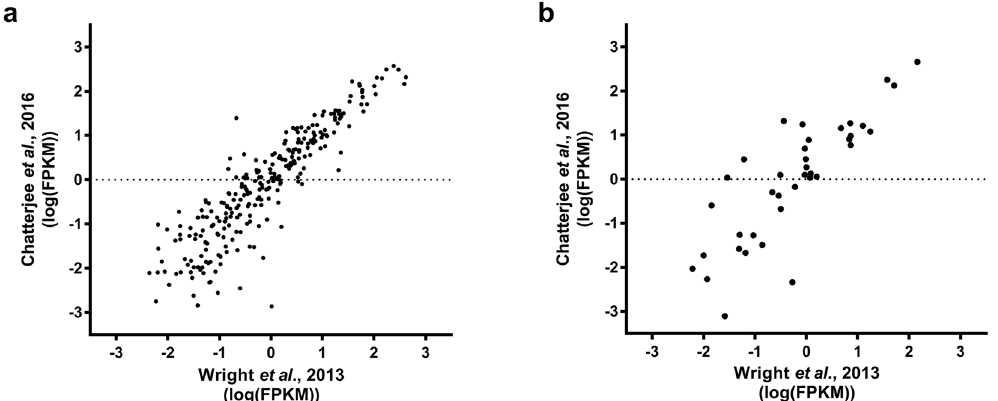
Figure 3. Expression of human SLC and ABC transporter proteins across two different datasets shows highly significant positive correlation. Scattergraphs show comparison of expression of ( a ) SLC and ( b ) ABC transporter proteins in datasets by Wright et al . and Chatterjee et al . 21, 33 . Data points represent the mean of replicate values. Any genes in the Wright et al . dataset which could not be identified in the Chatterjee et al . dataset are not shown. For ( a ), r = 0.9157, P < 0.0001 (Spearman correlation, n = 368 pairs). For ( b ), r = 0.8368, P < 0.0001 (Spearman correlation, n = 47 pairs). Corresponding tables are provided in Supplementary Tables S3 and S4.